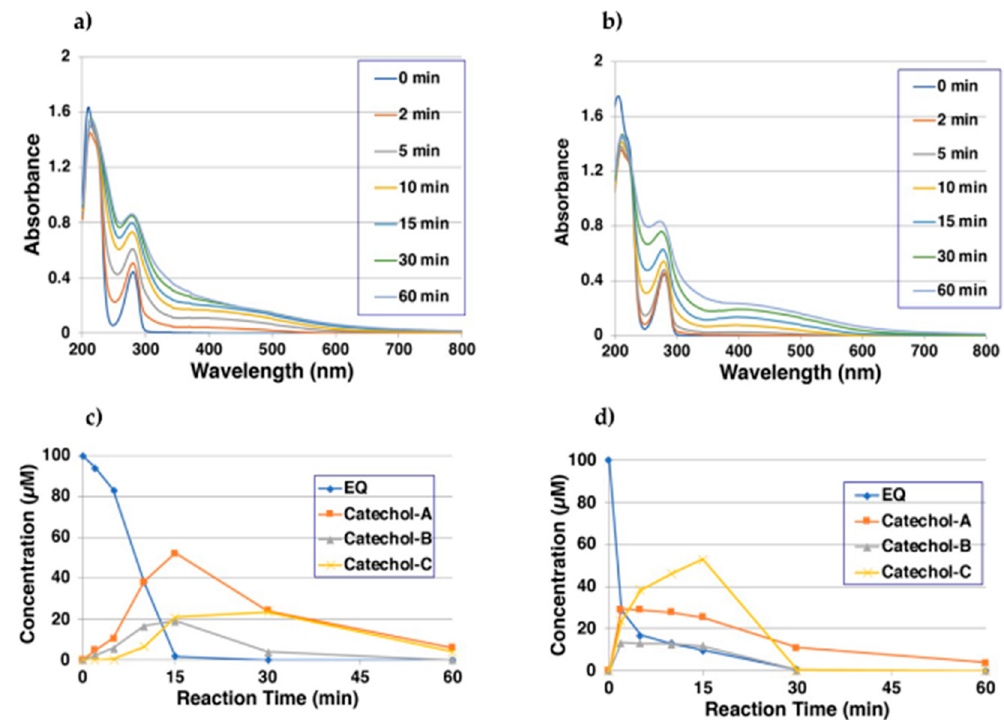
Figure 2. Time course of the tyrosinase-catalyzed oxidation of EQ 1 and HPLC analyses of reaction products. ( a ) UV/visible spectral changes of EQ 1 at pH 6.8; ( b ) UV/visible spectral changes of EQ 1 at pH 5.3; ( c ) HPLC analysis following the tyrosinase-catalyzed oxidation of EQ 1 at pH 5.3, the reaction being stopped by the addition of NaBH 4 , followed by HClO 4 ; ( d ) HPLC analysis following the tyrosinase-catalyzed oxidation of EQ 1 at pH 5.3 in the presence of 10 mol eq. AA, the reaction being stopped by the addition of HClO 4 . Data for ( a , b ) were obtained from single experiments, but reproducibility was confirmed for each experiment. Data for ( c , d ) were obtained from averages of two independent experiments.